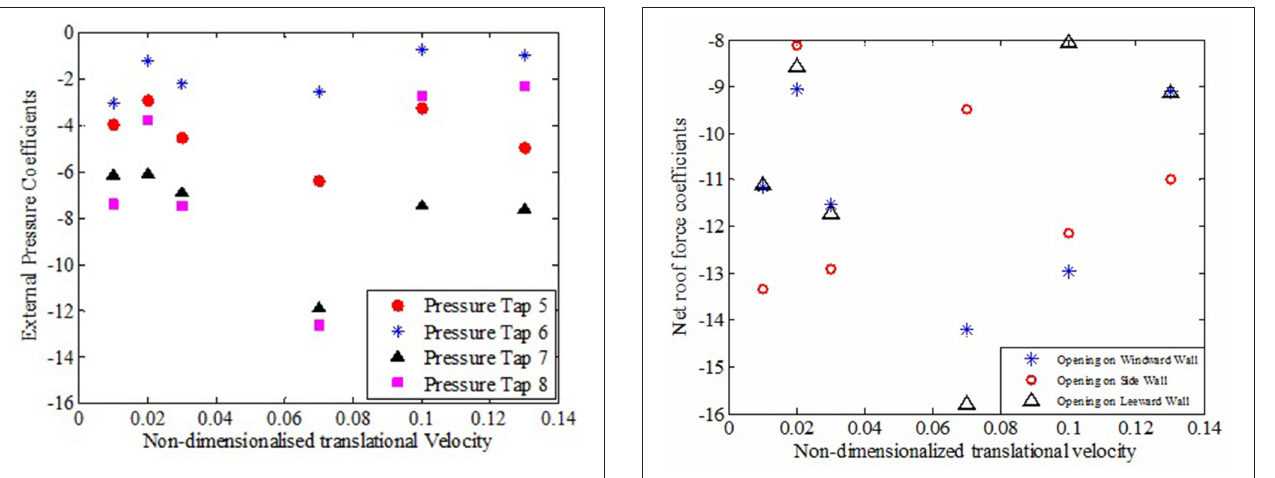
kept stationary at the center of floor of simulator and the updraft end of simulator to the other with the building model on the path.